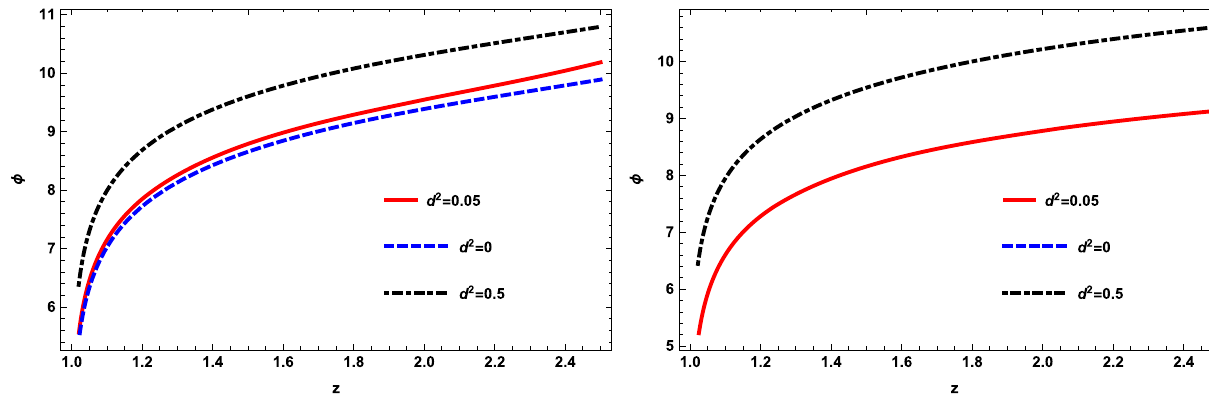
Fig. 5 Plot of φ verses z for u = 1 and u = 2 . 002 for quintessence scalar field model